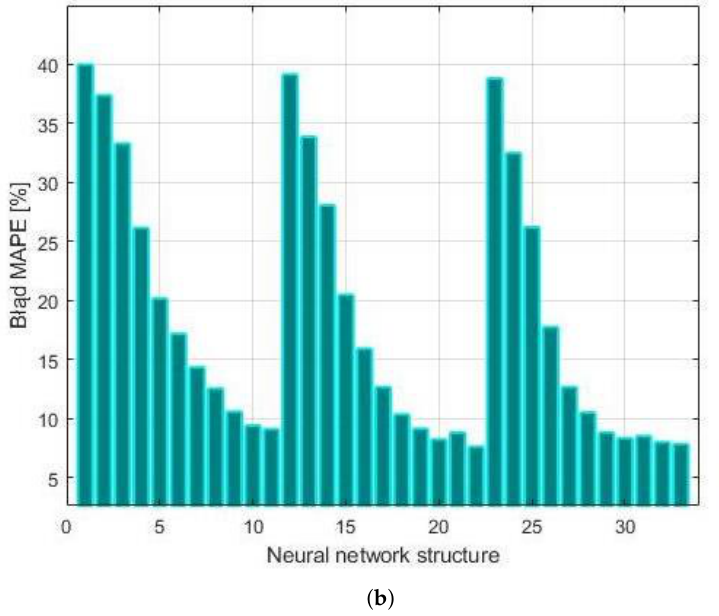
Figure 30. Comparison of neural network structures for wind power plant FW4. ( a ) MAE. ( b ) MAPE.